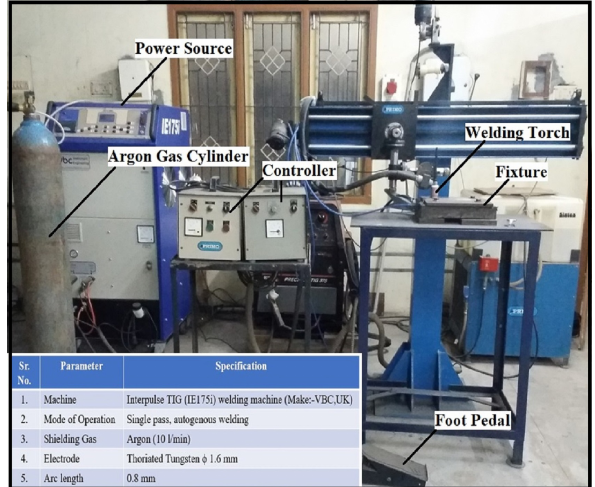
Figure 2: GTCA welding machine set